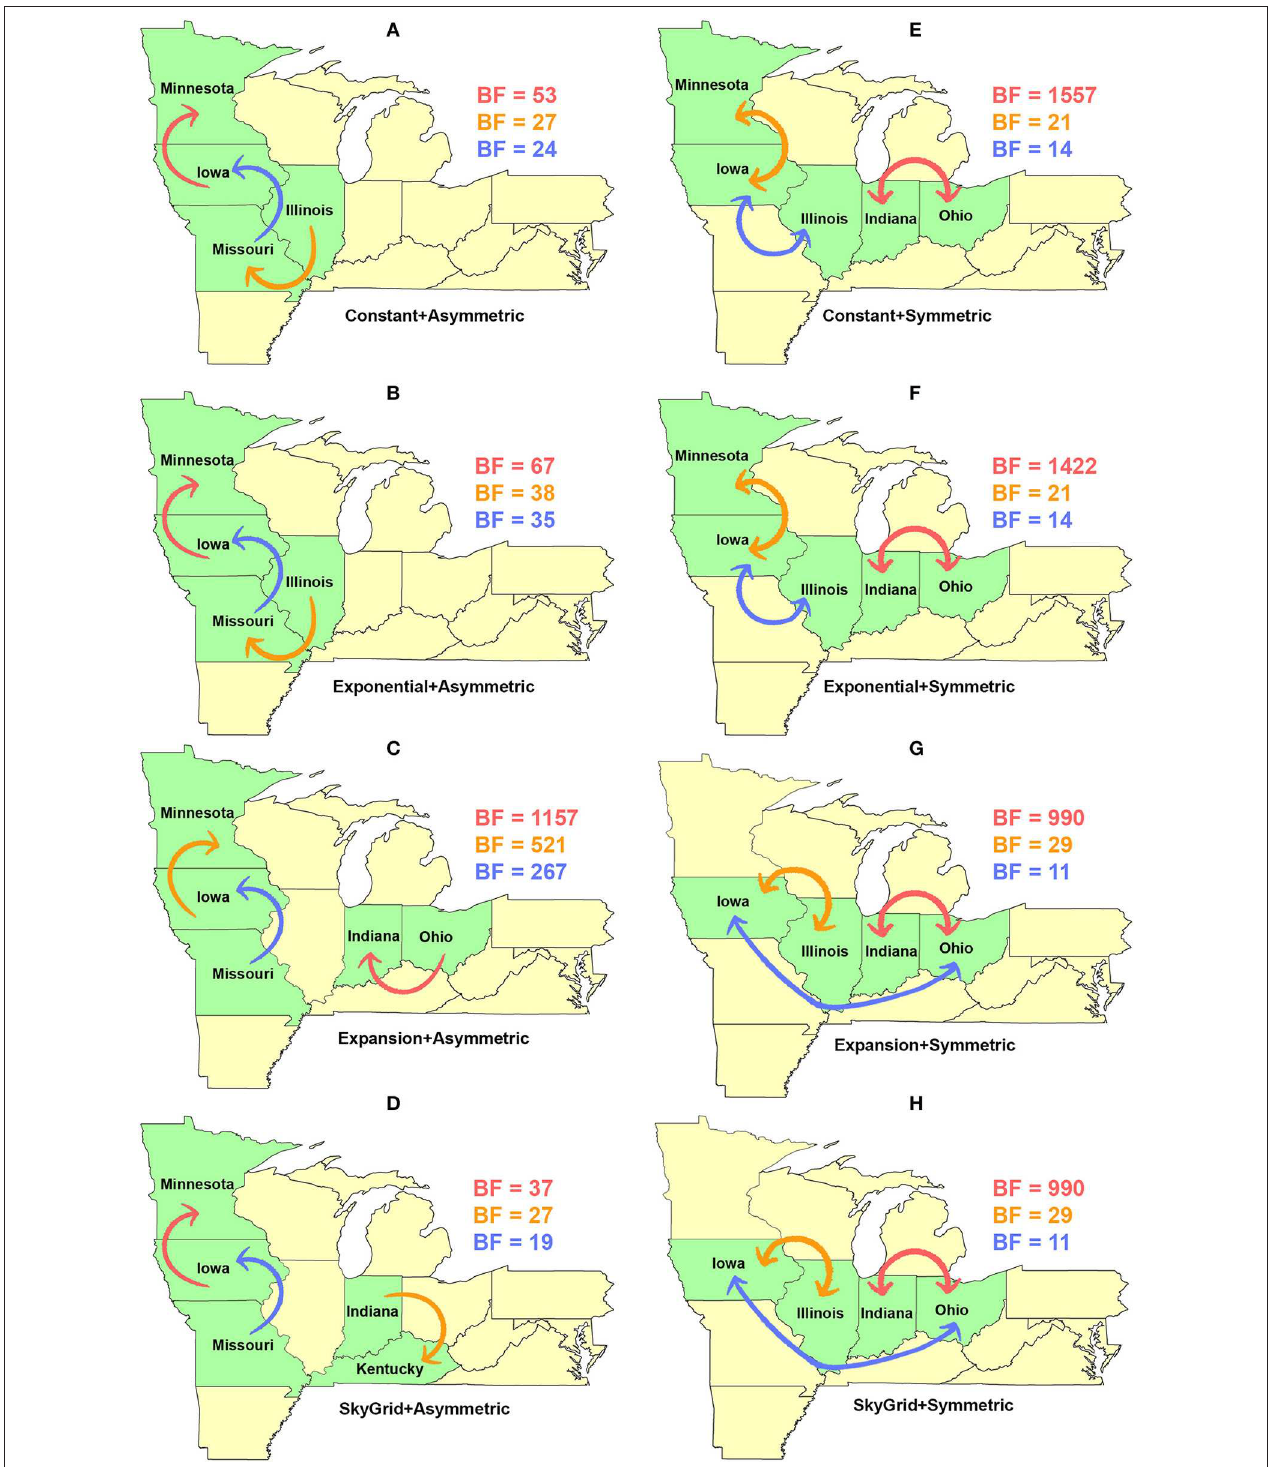
FIGURE 7 | Dispersal routes of human-like H3 swine influenza virus between states inferred from the HA gene segment. Dispersal routes with non-zero rates were inferred using the Bayesian stochastic search variable selection (BSSVS) approach, and statistically significant routes were selected using Bayes factors (BF). The top three dispersal routes with the strongest statistical support (by the BFs) are plotted. Arrows’ colors correspond to the color legend of their BF values on the upper right of each map. (A–D) Dispersal routes inferred from four node-age + asymmetric BSSVS priors. (E–H) Dispersal routes inferred from four node-age + symmetric BSSVS